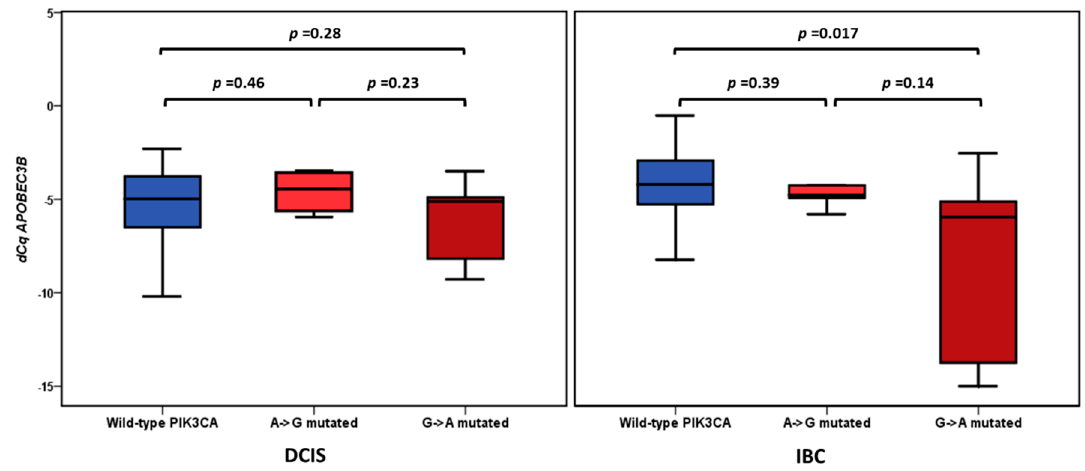
Figure 4. Boxplots of APOBEC3B mRNA expression levels according PIK3CA mutation status. The differences between wild-type (blue boxes) and mutated (red boxes) PIK3CA cases were analyzed by the Mann-Whitney U test.